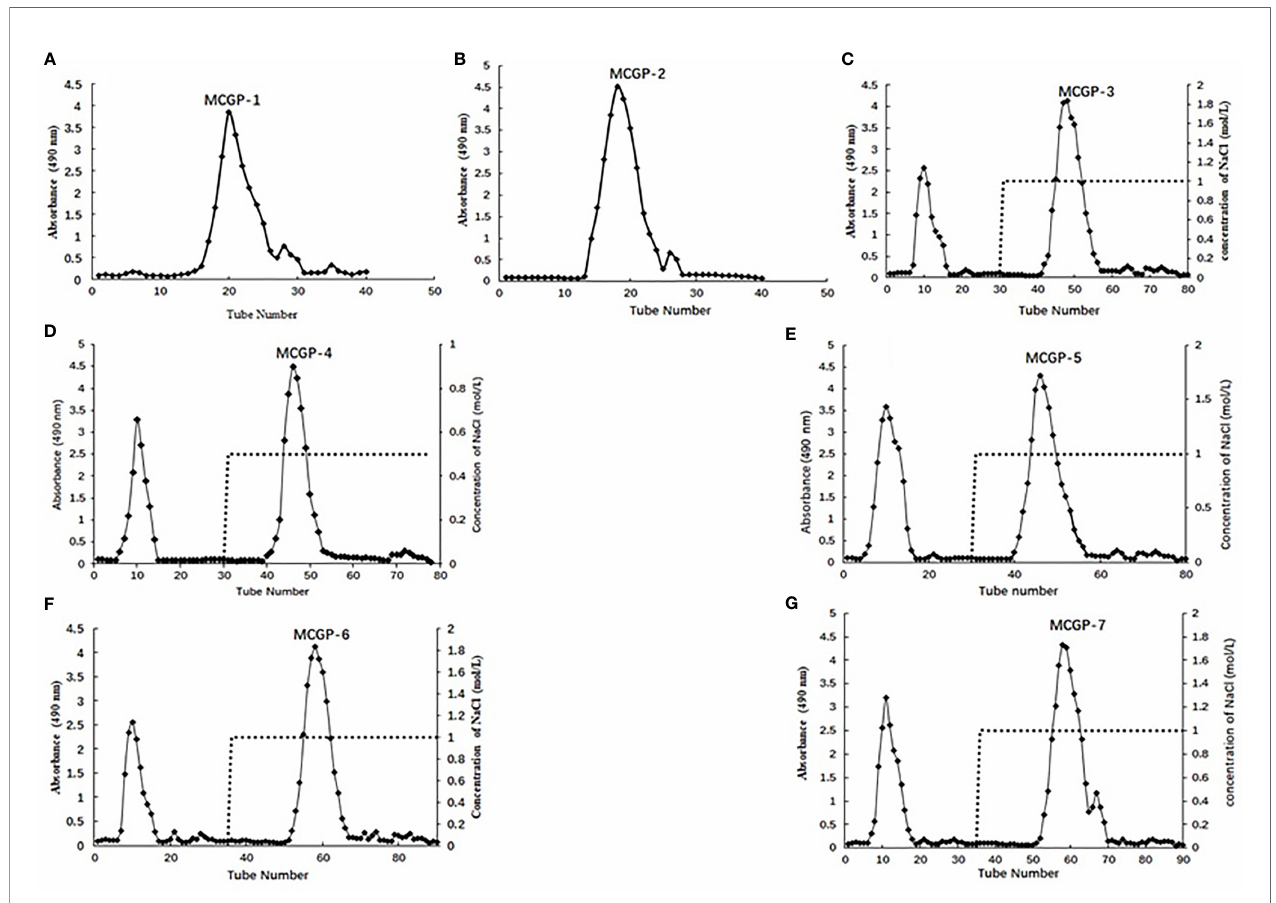
FIGURE 1 | (A, B) Elution pro fi les of MCGP-1, MCGP-2 on a Sephadex G-25 column, (C – G) MCGP-3~MCGP-7 on DEAE-52 column, eluted with H 2 O and different concentration of NaCl,